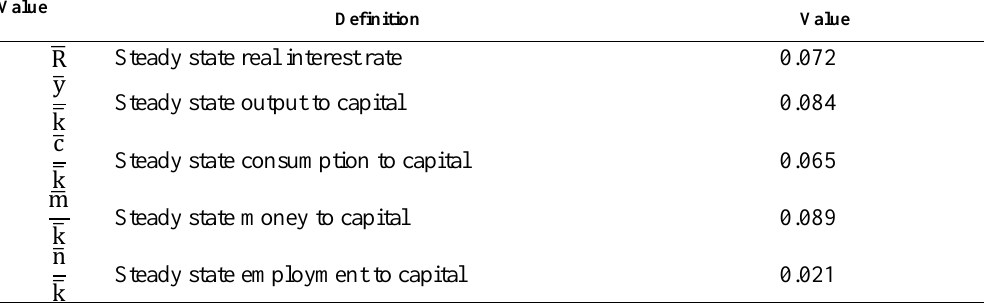
Table 2. Steady-State Values at Baseline Parameter